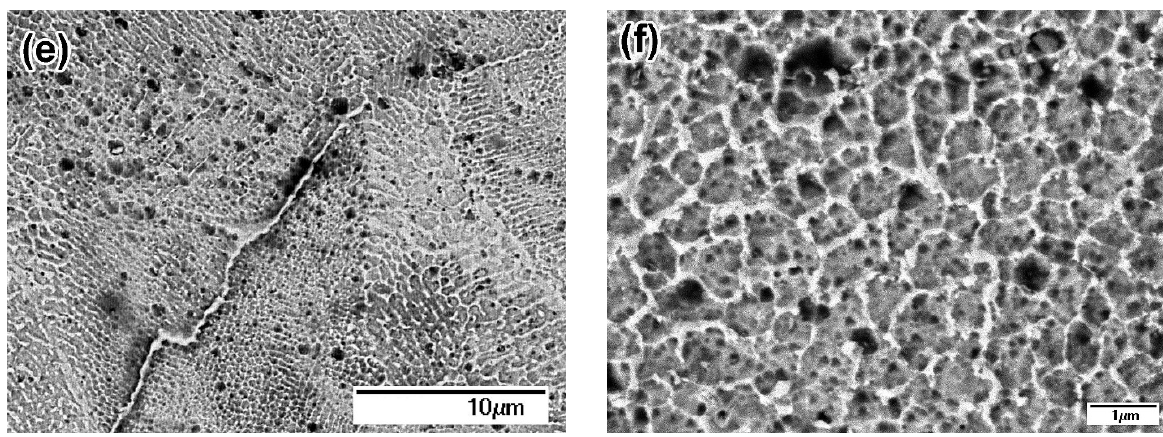
Figure 8. SEM images of pulsed-plasma-treated specimens: ( a , b ) plate 316T, ( c – f ) LPBF 316L (( a , c , e , f )—SEI; ( b , d )—BSE). Figure ( d ) refers to square 1 in Figure ( c ). Figs. ( e , f ) refer to rectangle 2 in Figure ( c ).